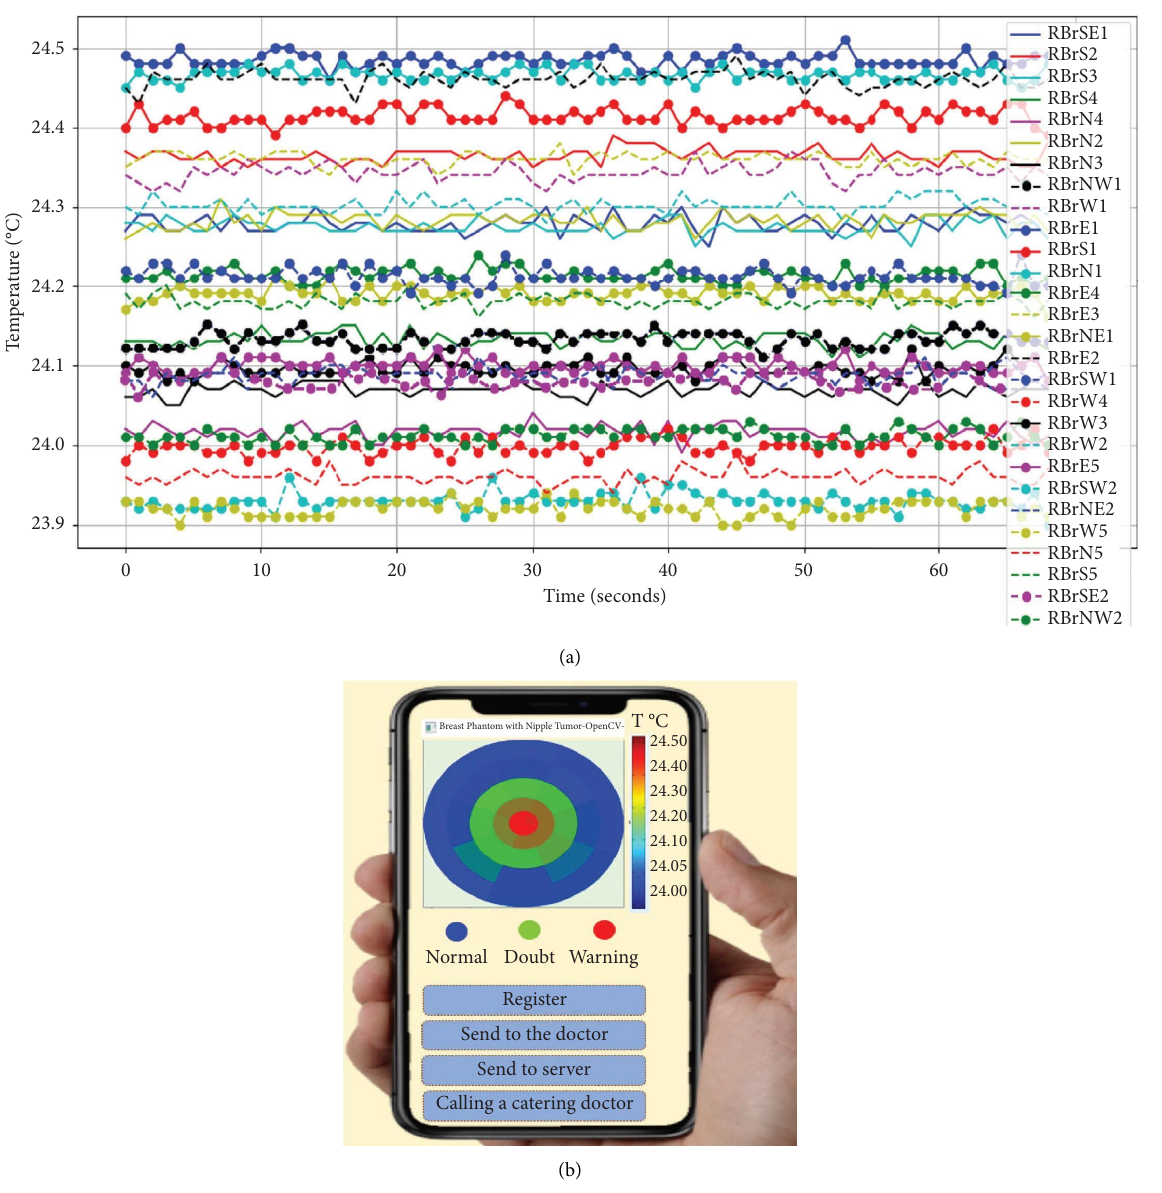
Figure 14: Temperature distribution of the right breast phantom with a nipple tumor integrated at 15 mm. (a) Variation in several bioheat microsensors and (b) thermal distribution with OpenCV on smartphone